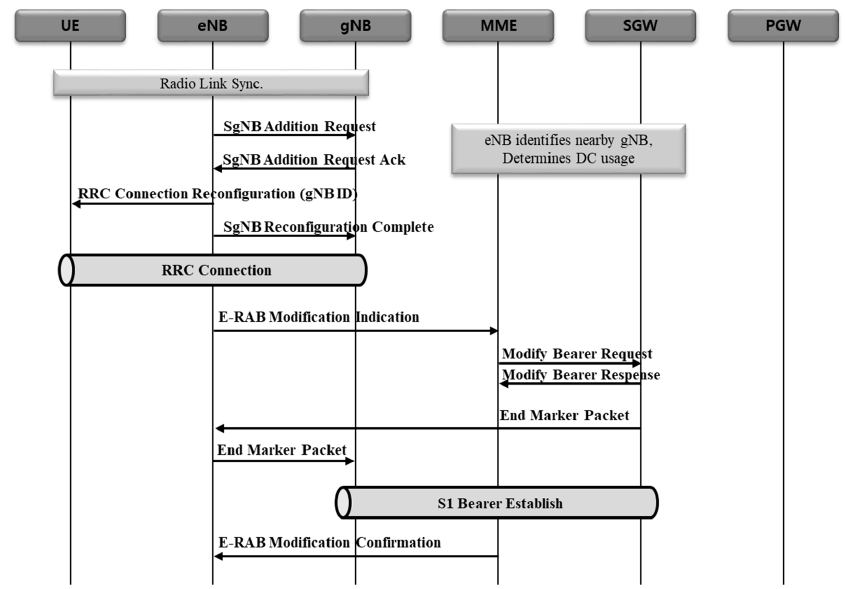
Figure 6. gNB DRB and S1 GTP-U tunnel creation.